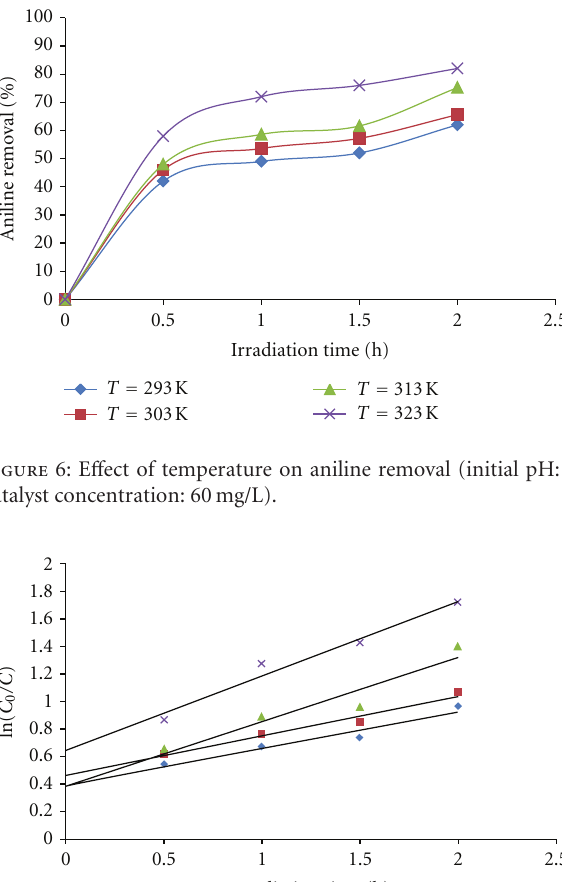
(11) under conditions (pH of 6, catalyst concentration of 60 mg/L) at four di ff erent temperatures (293, 303, 313, and